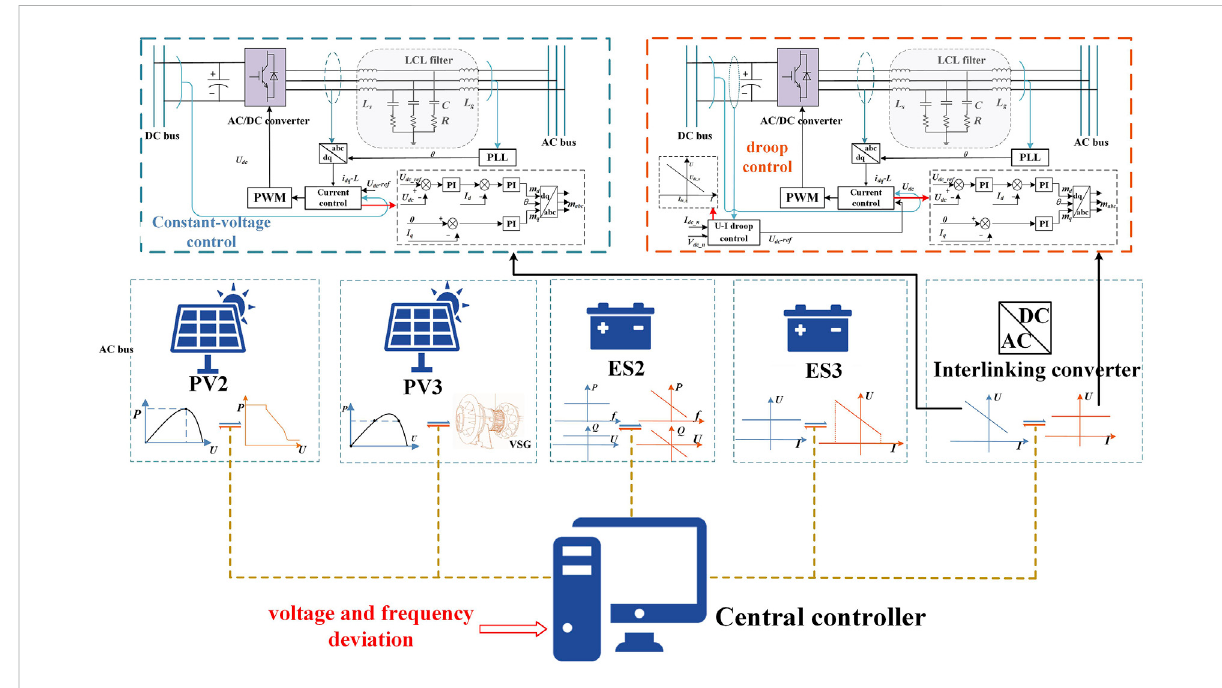
FIGURE 7 The control diagram of the interlinking